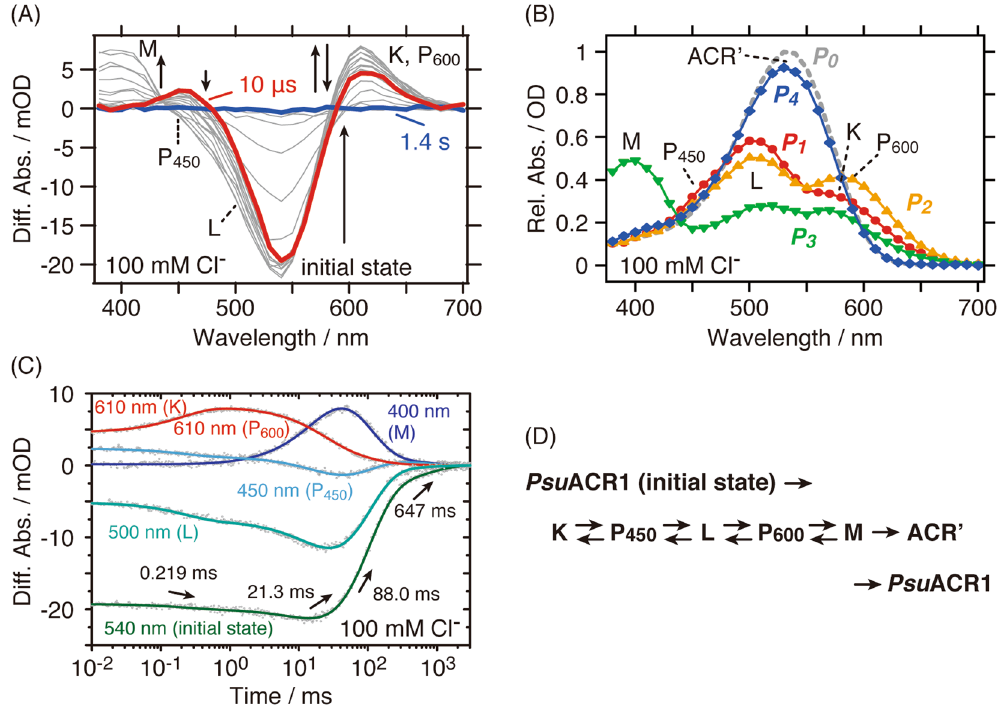
Figure 2. Photocycle kinetics of Psu ACR1 in the presence of 100 mM Cl − . ( A ) Flash-induced light minus dark difference absorption spectra. Red and blue lines represent the spectra at 10 μ s and 1.4 s, respectively. The directions of the evolution of the spectral changes are indicated by arrows. ( B ) Absorption spectra of the P 1 – P 4 states (red circles, orange triangles, green inverted triangles and blue diamonds, respectively) calculated from the fitting results. The spectrum of P 0 (grey broken line) represents the pure retinal spectrum. ( C ) Time evolution of flash-induced absorption changes (shown as grey dots) of the initial state (540 nm), K and P 600 (610 nm), L (500 nm), P 450 (450 nm) and M (400 nm), respectively. Fitting curves are shown as solid lines with colors. Time constants are shown in the same panel. ( D ) Photocycle scheme in the presence of 100 mM Cl −